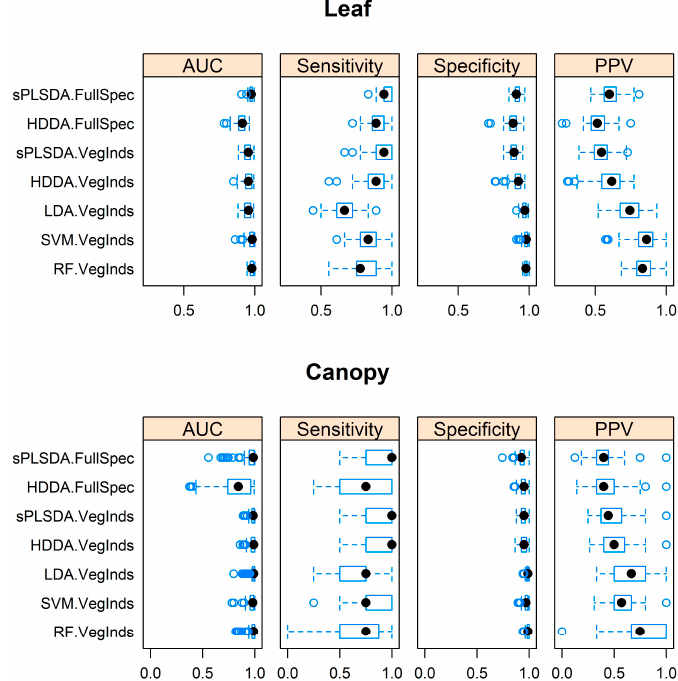
Figure 2. Model performances (Area Under Curve (AUC), Sensitivity, Specificity, Positive Predictive Value (PPV)) after 100 iterations of distinguishing Acacia longifolia from adjacent Mediterranean dune vegetation for full spectrum data (*.FullSpec) and vegetation indices (*.VegInds) at leaf ( top ) and canopy ( bottom ) level applying sparse Partial Least Square Discriminant Analysis (sPLSDA), High-Dimensional Discriminant Analysis (HDDA), Linear Discriminant Analysis (LDA), radial basis function kernel Support Vector Machine (SVM), and Random Forest (RF) as classifiers.